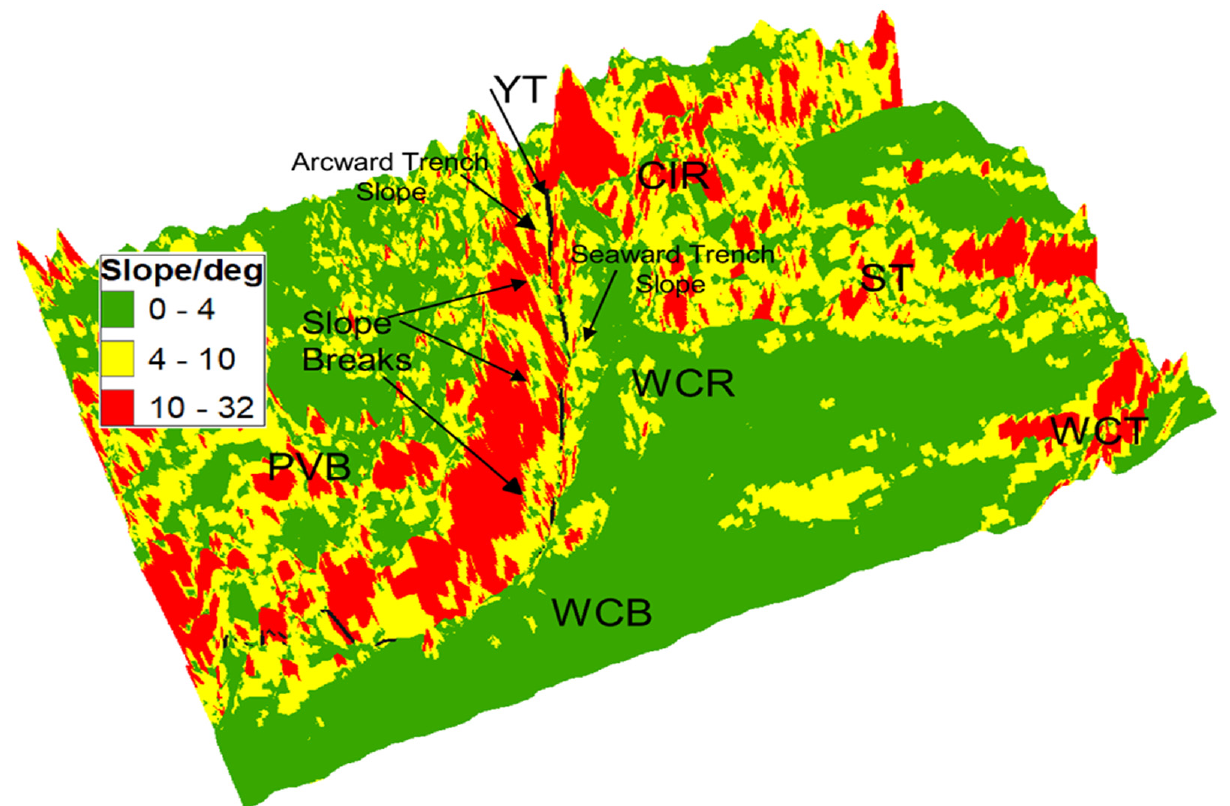
Figure 6. The influence of the CR subduction on the formation of the slope values of the arc-ward and sea-ward trench slopes. Slope breaks can be identified in places where slope values vary rapidly. The sea-ward trench slope is dominated by abnormally high slope values due to increased compressional force at the Yap Trench axis caused by the subducting CR. See Figure 1 for abbreviations.